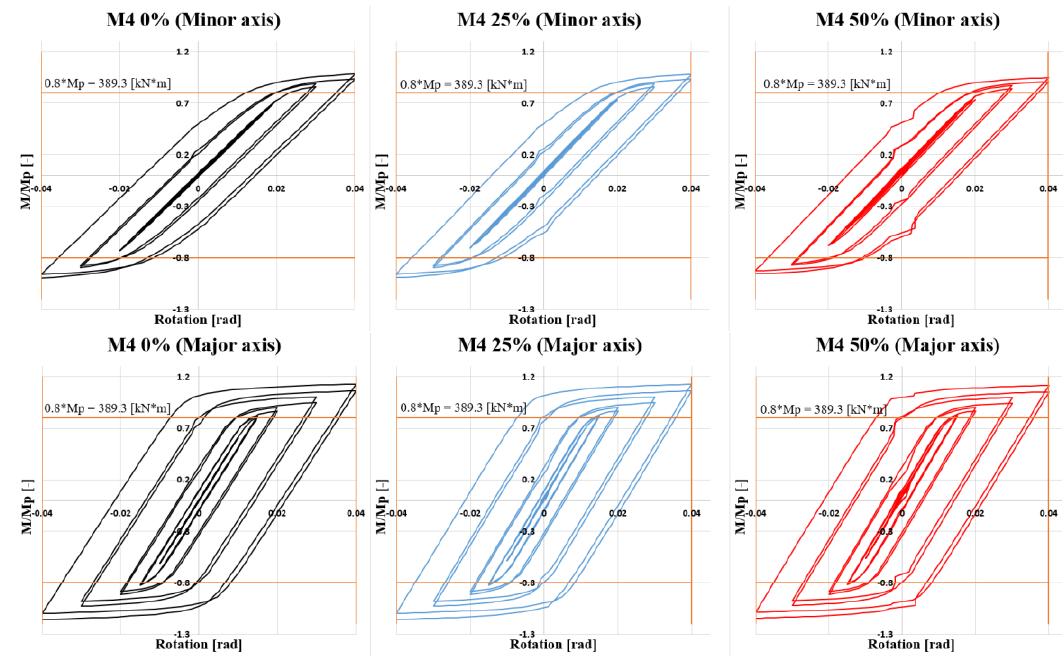
Figure 12. Normalized moment-rotation curves at each east beam.